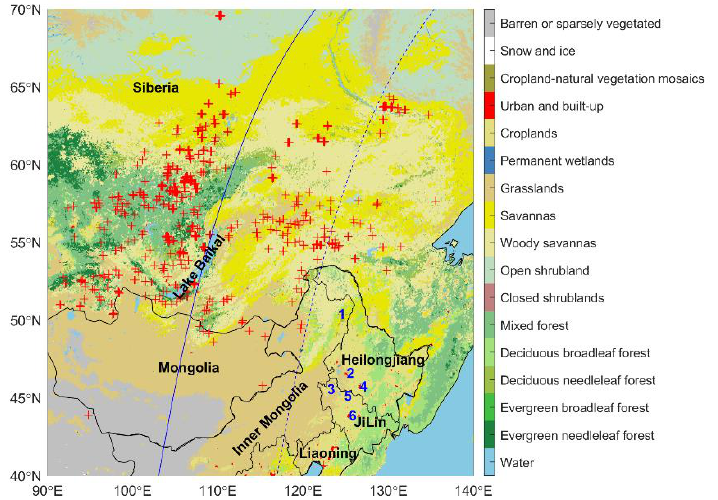
Figure 1. The MODIS land cover map and active fire points (plus simple: red color) measured by Aqua MODIS from 20 June to 30 June 2017 in Northeast Asia. The spatial distribution of six PM2.5 stations is marked with blue numbers. The solid blue line is the ground track of the CALIPSO satellite on 25 June 2017, and the dashed blue line is the track on 26 June